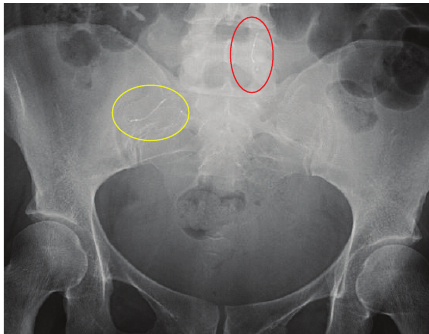
Figure 2: Patient Number 1, postpartum pelvic X-ray 8/30/2014: Essure (circled in red) in the abdomen.